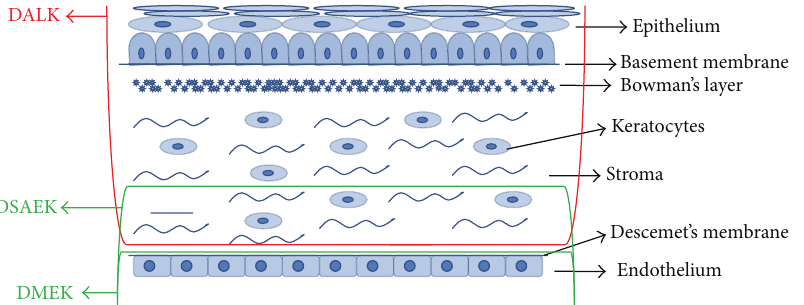
Figure 1: Different layers of a corneal tissue and types of surgeries that involve specific layers. DALK replaces the anterior part, whereas DMEK and DSAEK replace the posterior part of the